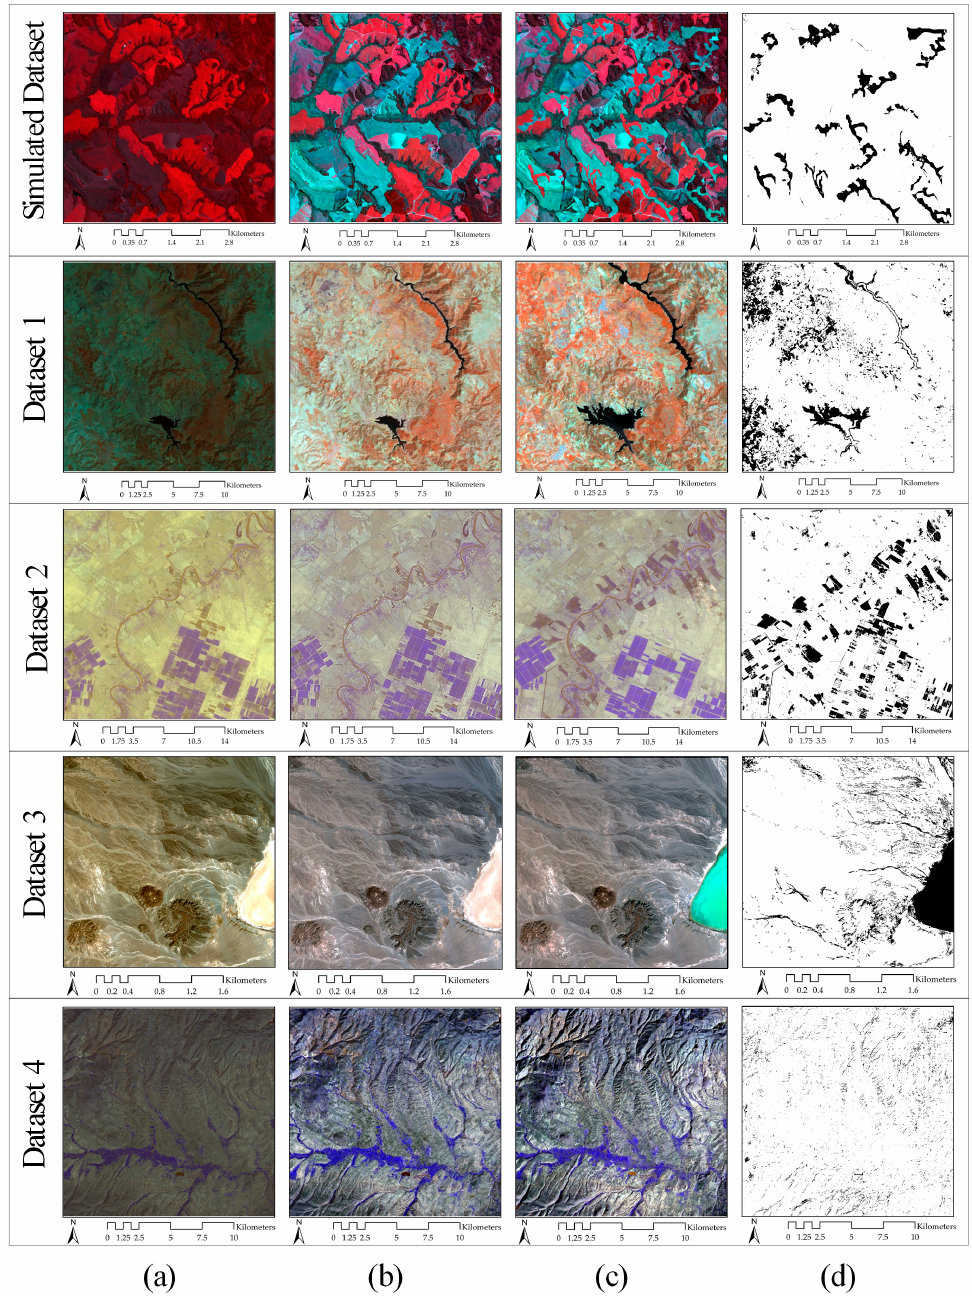
Figure 3. The color composites of considered datasets, and the corresponding normalized target images and binary change maps. ( a ) target images, ( b ) normalized target images generated by the proposed method, ( c ) reference images, and ( d ) binary change maps (black = changed, white =un- changed). False-color composites (NIR/red/green) and (green/red/NIR) were respectively used for the simulated dataset and datasets 1, 2, and 4, whereas the natural color composite (Red/Green/Blue) was employed for datasets 3 for visual assessments.